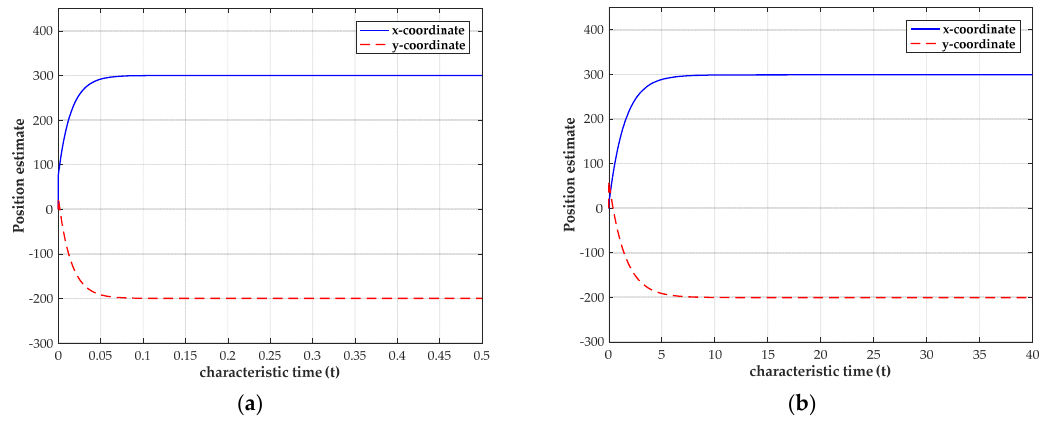
Figure 4. Transient behavior of the estimated source coordinates with the source position located at ( 300, − 200 ) m. ( a ) Transient behavior when σ 2 = 0.01 m 2 ; ( b ) transient behavior when σ 2 = 1 m 2